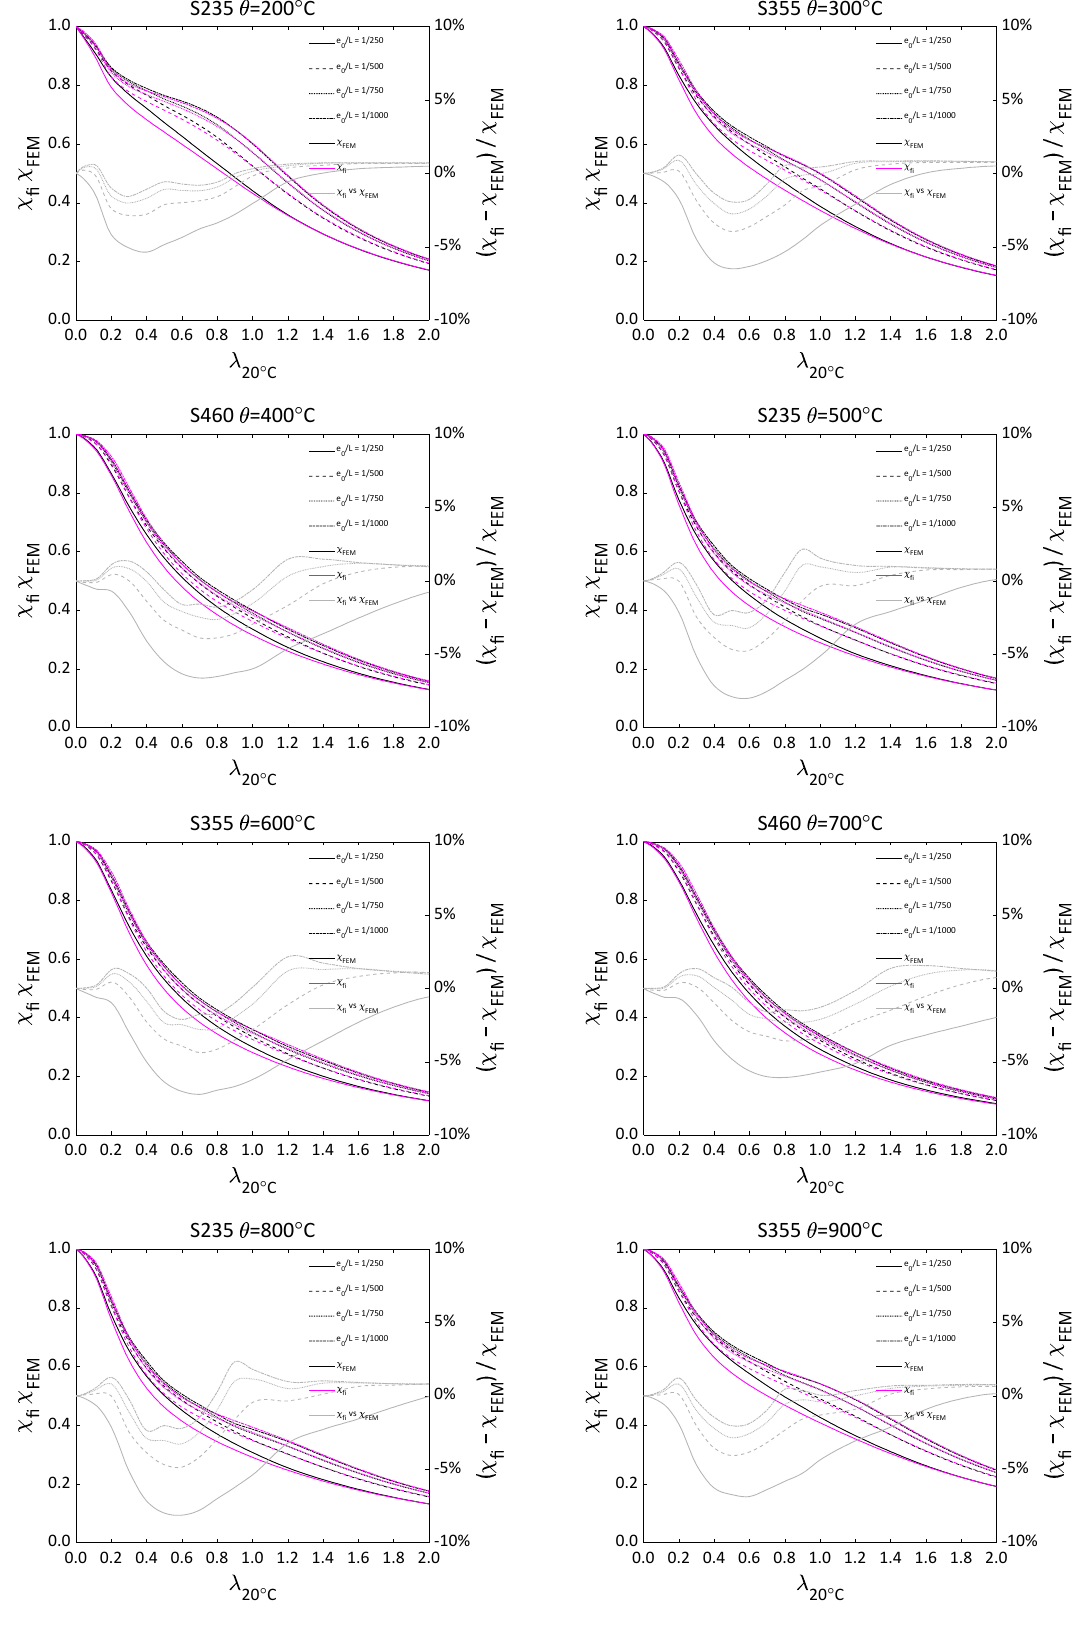
Figure 7. Performances of the proposed method against non-linear FEM for different steel grades, heating temperatures and initial imperfection values.